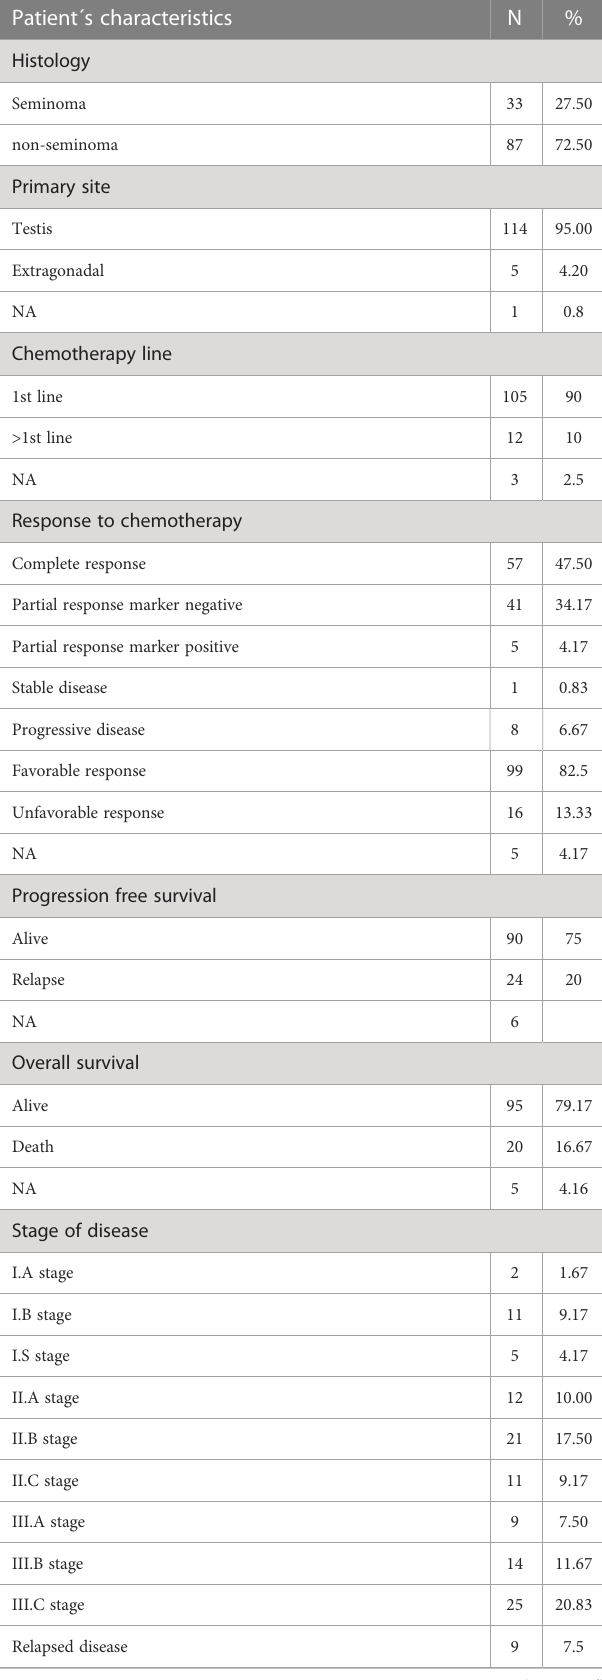
TABLE 1 Patients ’